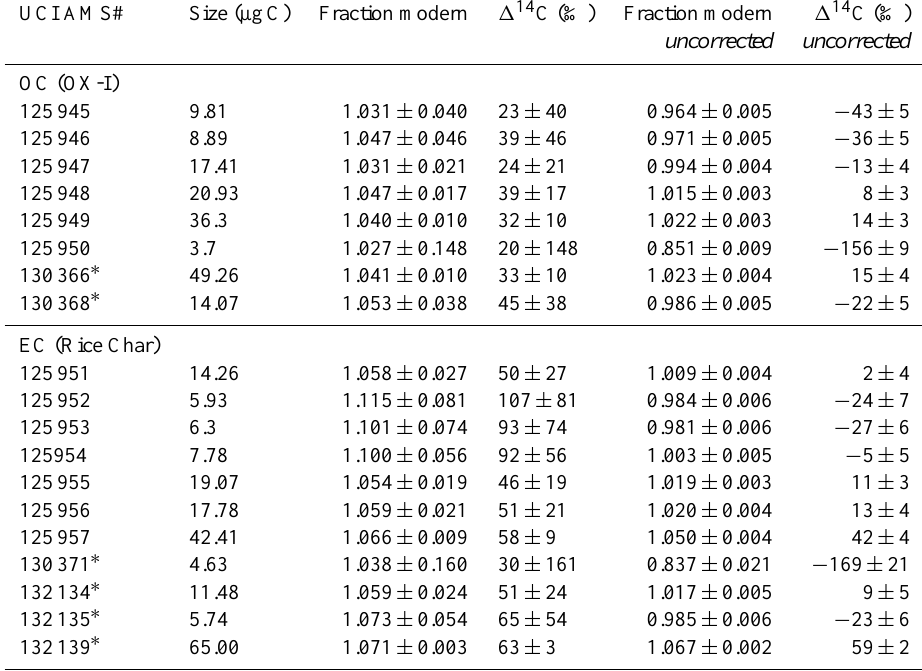
Table A1. Radiocarbon measurements of reference materials with a known fraction modern value (standards). The table includes the results both after and before background